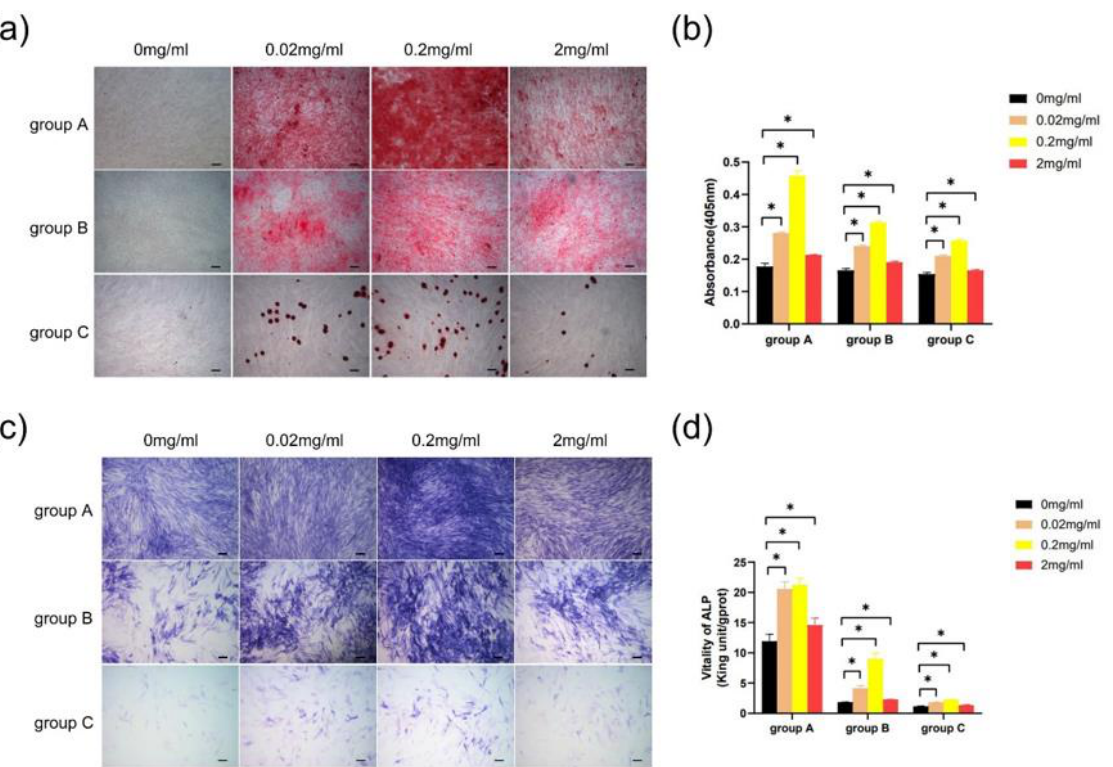
Figure 8. Effects of Biodentine on the mineralization of hDPSCs. ( a ) Images of alizarin red S staining (scale bar: 200 µ m). ( b ) Quantitative measurement of alizarin red staining of hDPSCs cultured with different concentrations of Biodentine extracts. ( c ) Images of ALP staining (scale bar: 200 µ m). ( d ) ALP activity test. * p < 0.05, versus